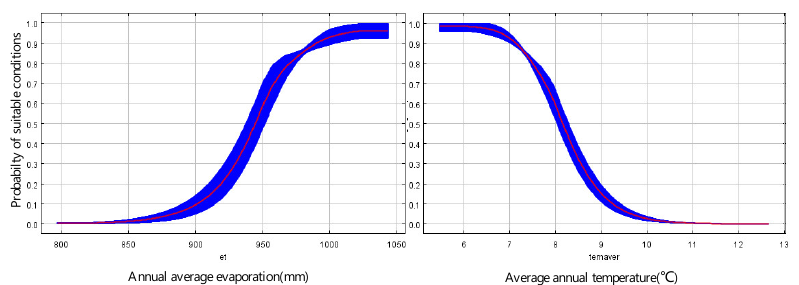
Figure 6. Average response curves of the main predictor variables of the modeled distribution of Artemisia sacrorum on the MaxEnt algorithm.